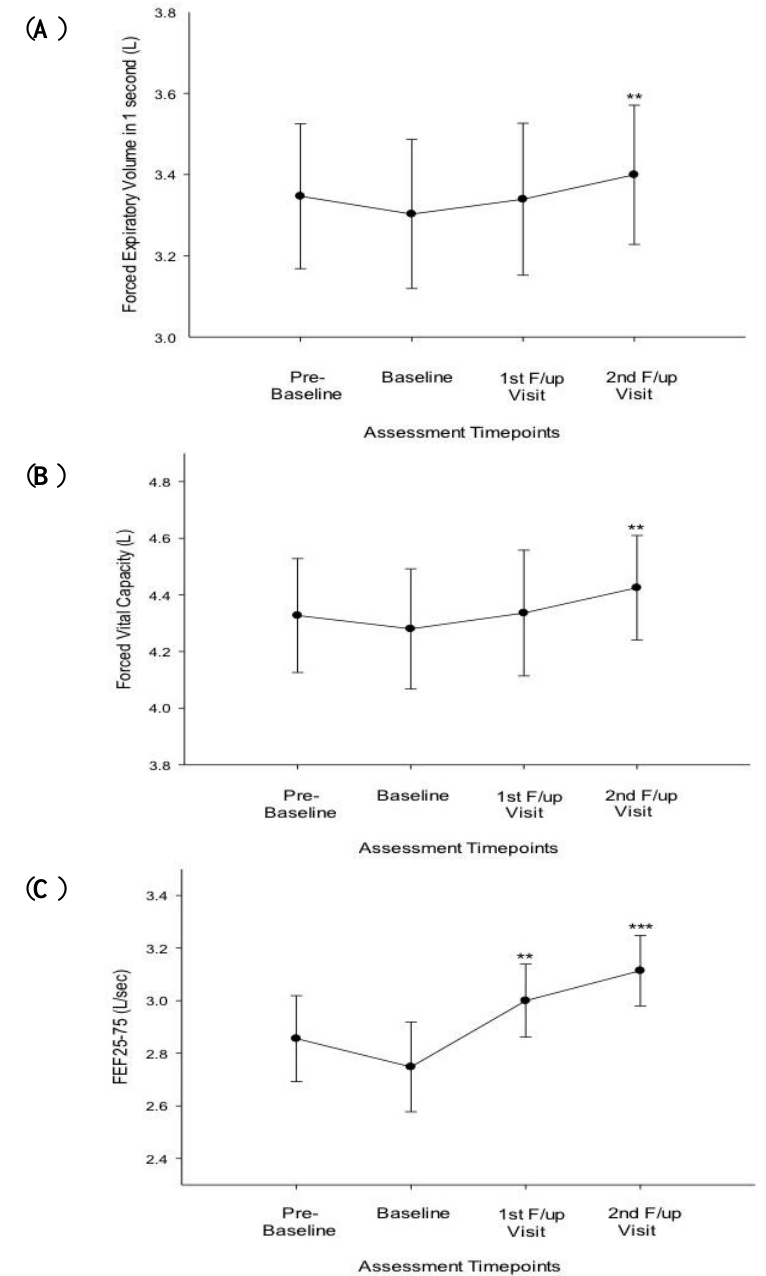
Figure 1. ( A ) Forced expiratory volume (FEV1) at the four timepoints of assessment for all 18 patients; ( B ) Forced vital capacity (FVC) at the four timepoints of assessment for all 18 patients; ( C ) Forced expiratory flow (FEF) 25–75 at the four timepoints of assessment for all 18